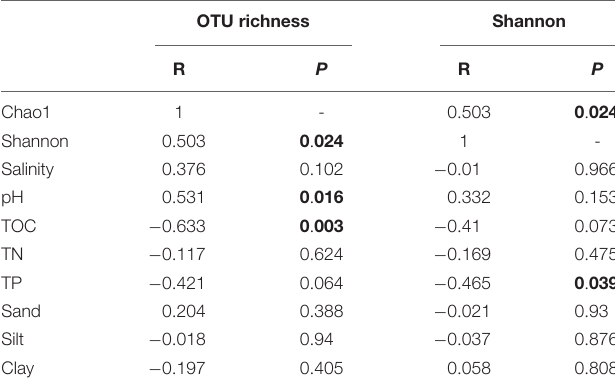
TABLE 3 | Summary of Pearson’s correlation between the richness and diversity of microbial community, and physicochemical properties of